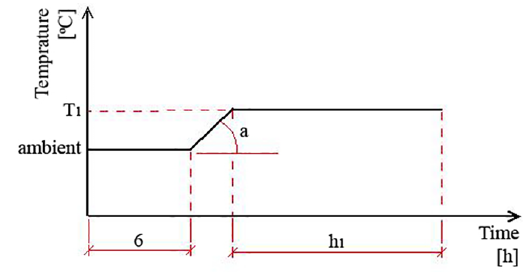
Figure 4. The curing cycle applied together with the parameters of the Taguchi design of the experiments. Ambient temperature is considered equal to 23±1°C, a is the heating rate [°C/min], T curing temperature [°C] and